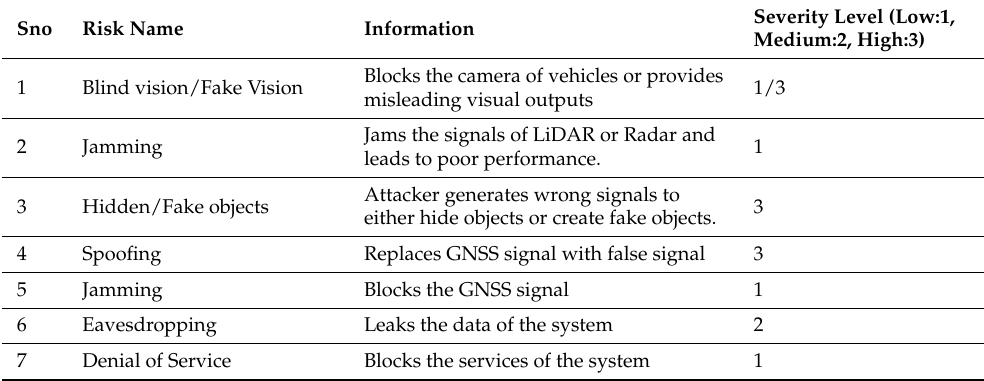
Table 1. Types of attack in maritime